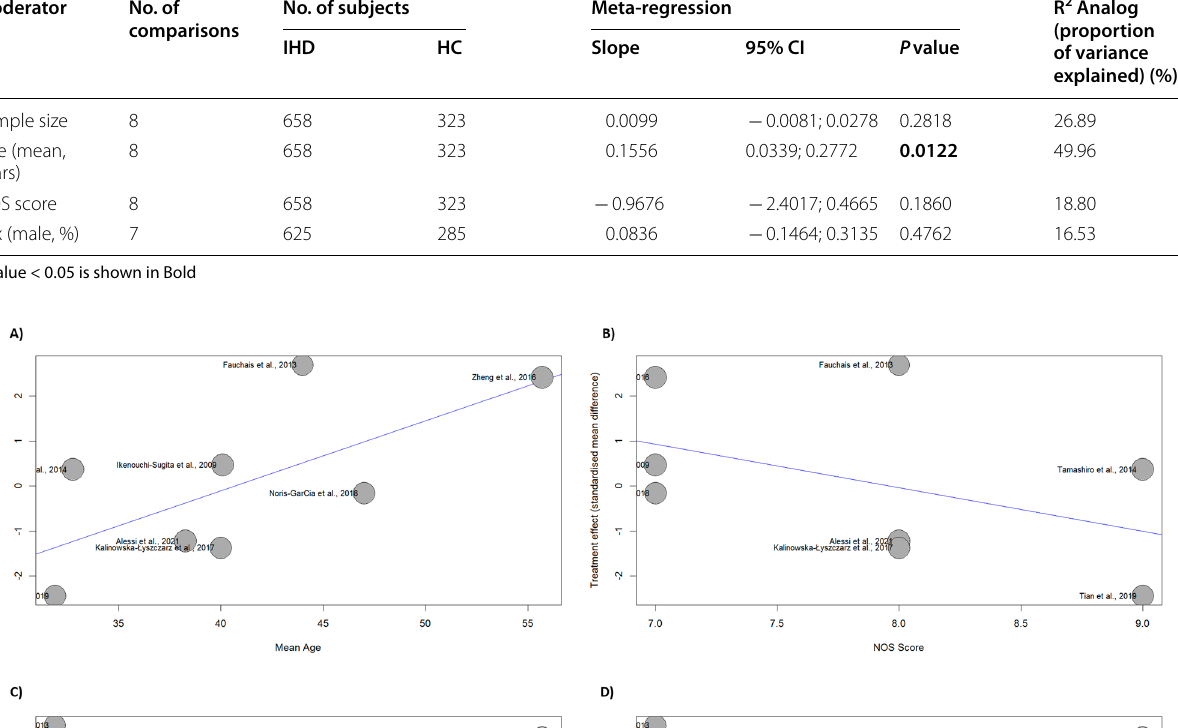
Table 3 Meta-regression of BDNF levels in SLE patients and healthy controls